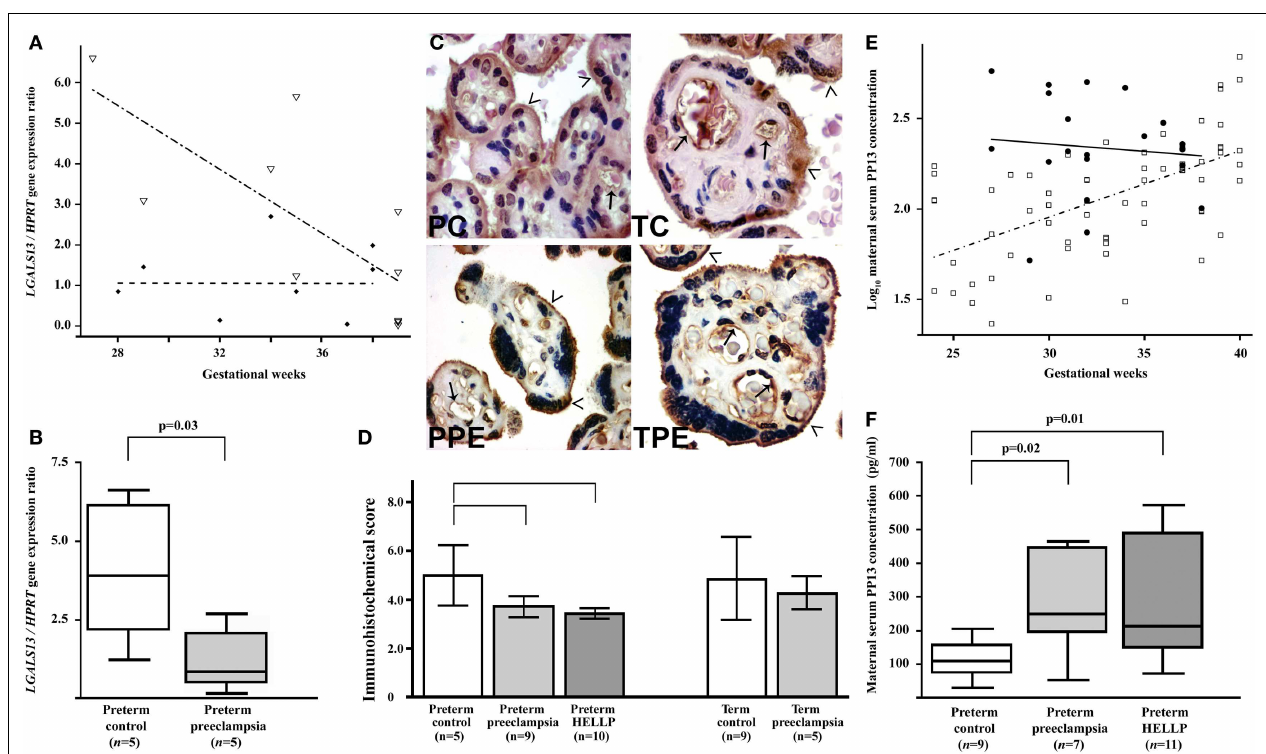
(left) or 700 × (right) magnification. (D) The immunohistochemical score of the syncytiotrophoblast is higher in preterm controls than in preterm preeclampsia, with or without HELLP syndrome, while it is not different between cases and controls at term. (E) Maternal serum log 10 PP13 concentrations increase as a function of gestational age in control women (open rectangle), while these do not correlate with gestational age in patients with preeclampsia (filled circle).The regression line for log 10 PP13 concentrations is significantly different in the two groups. (F) Median maternal serum PP13 concentrations are higher in women with preterm preeclampsia, with or without HELLP syndrome, than in controls. All the figures were published in Ref. (36). Kind permission for the reuse of figures was obtained from Springer Science + Business Media.